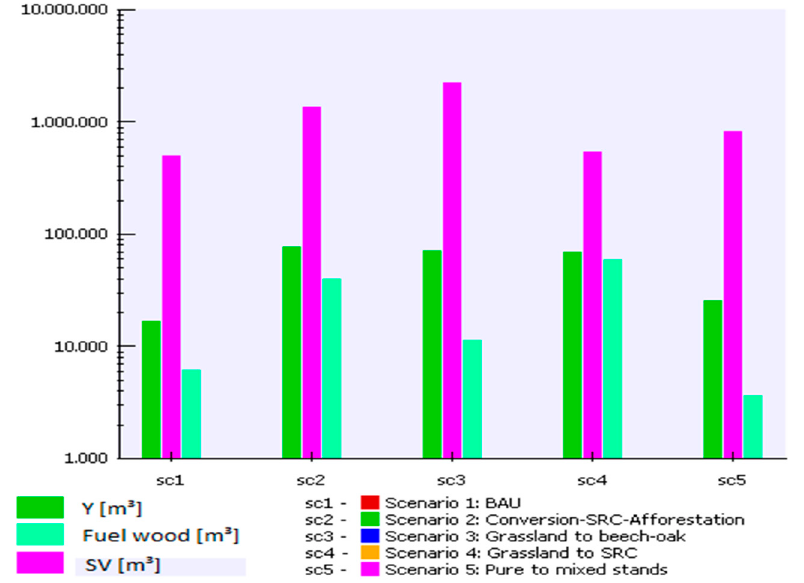
Figure 9. Five scenarios for the focus area Müglitz Valley at the time step 6 (after 100 years). Yield (Y), standing volume (SV), and the assortment fuel wood are illustrated. The colors of the scenarios correspond to Figure